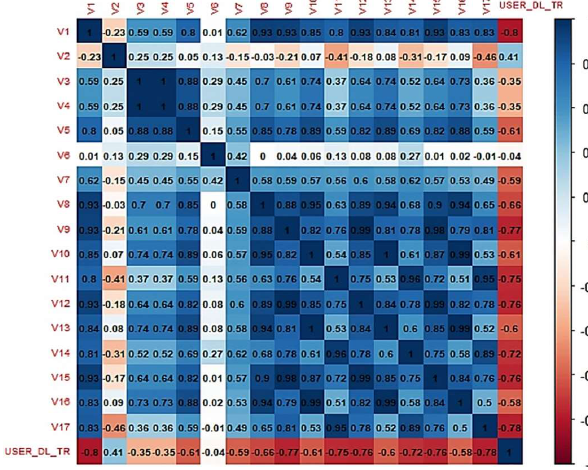
Figure 5. Matrix of Pearson correlation coefficients (correlogram) of research variables for the M17 trunk road section,